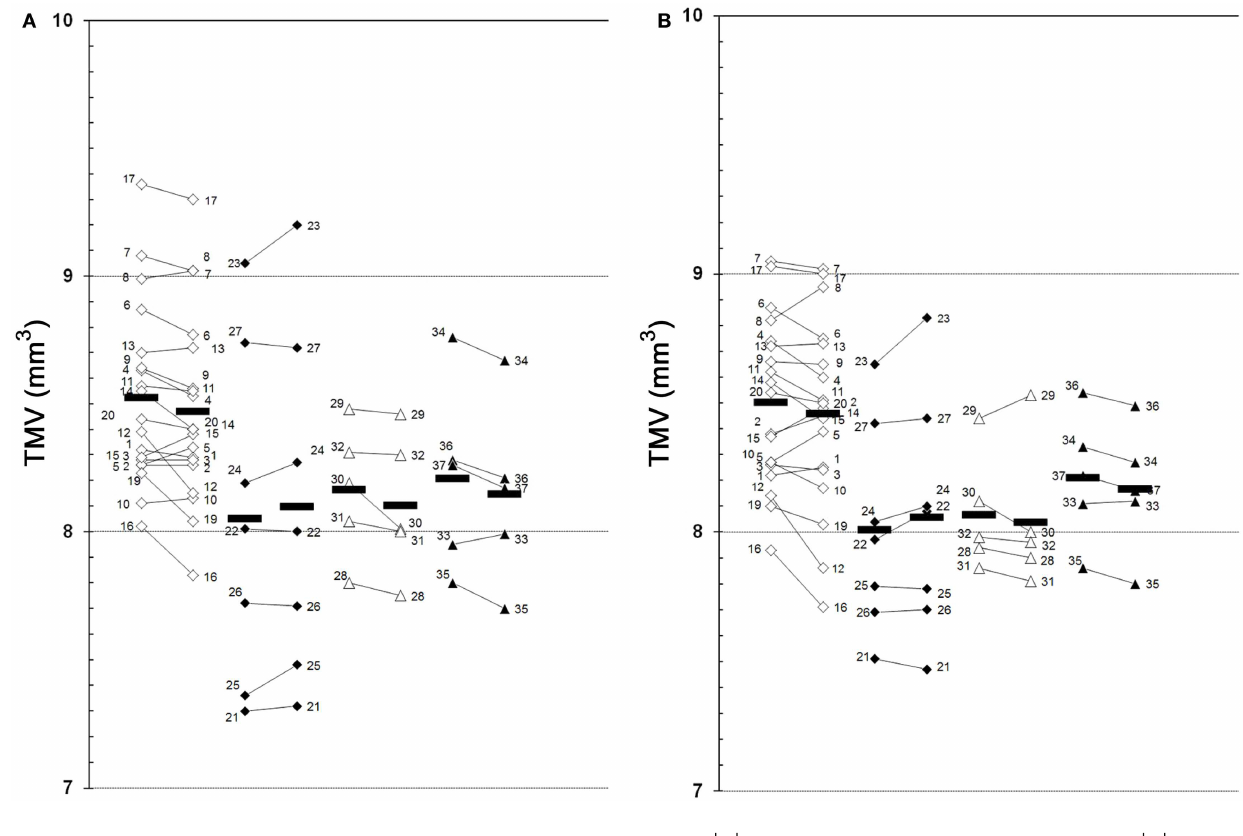
FIGURE 1 | GlobalTMV changes between baseline and follow-up examination . (A) , left eye; (B) , right eye; 1–37, patient 1–37 (see Table 1 for demographic and clinical data); white squares, RRMS without ON